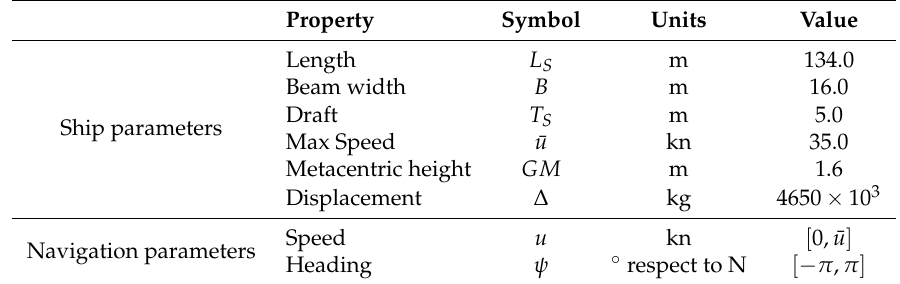
Table 1. Ship and navigation parameters used in the ship-modeling component and values for a typical multi-role patrol frigate. Property